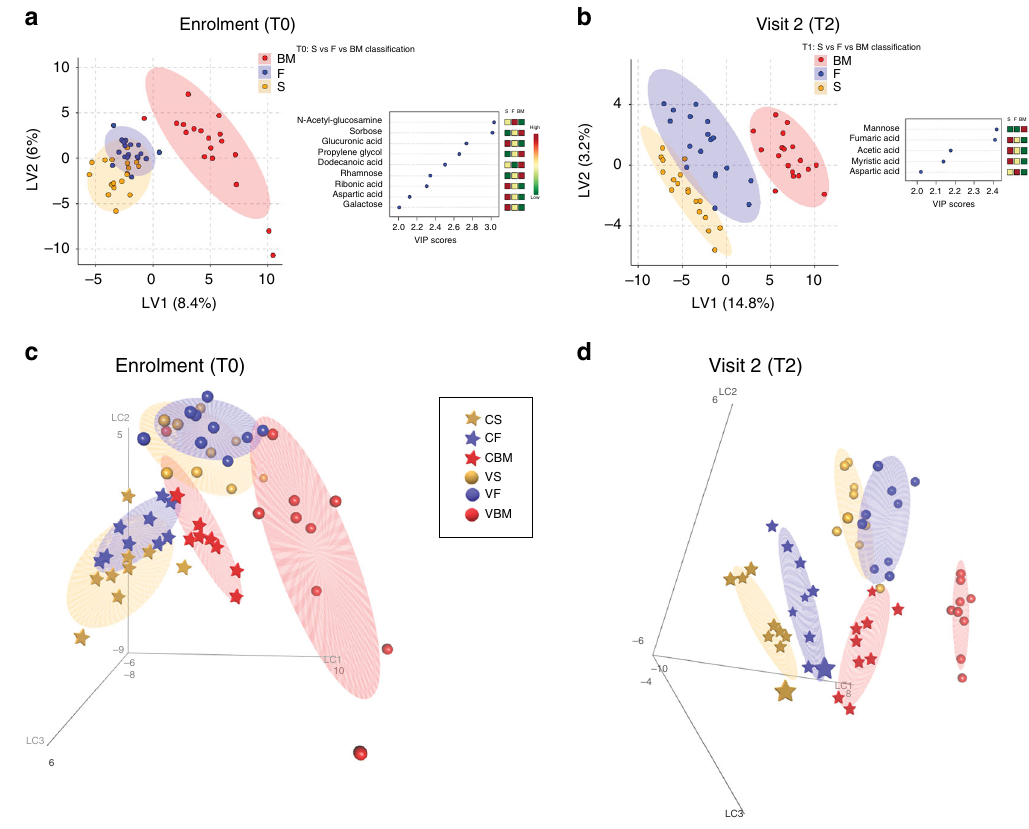
Fig. 4 Metabolome clearly distinguishes newborns based on their dietary regimen. a , b Metabolomic assessment at enrolment ( a ) and at visit 2 ( b ) according to the type of feeding. Left, a PLS-DA analysis is shown separating infants breastfed (BM, red dots), fed formula F (F, blue dots), or formula S (S, orange dots). On the right are shown those metabolites that differentiate the three diets (VIP score > 2) and their mean relative concentration. c , d Metabolomic assessment (PLS-DA 3D) at enrolment ( c ) and at visit 2 ( d ) according to the type of feeding (BM — red; F — blue; S — orange) and mode of delivery (caesarean — star; vaginal — sphere). CBM caesarean delivery breast milk feeding, CF caesarean delivery fermented formula feeding, CS caesarean